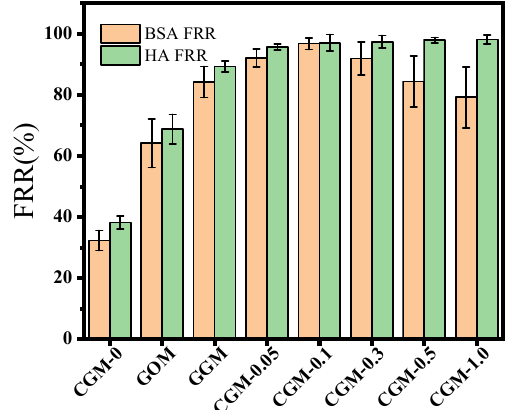
Figure 11. Flux recovery rate of different membranes in one cycle.